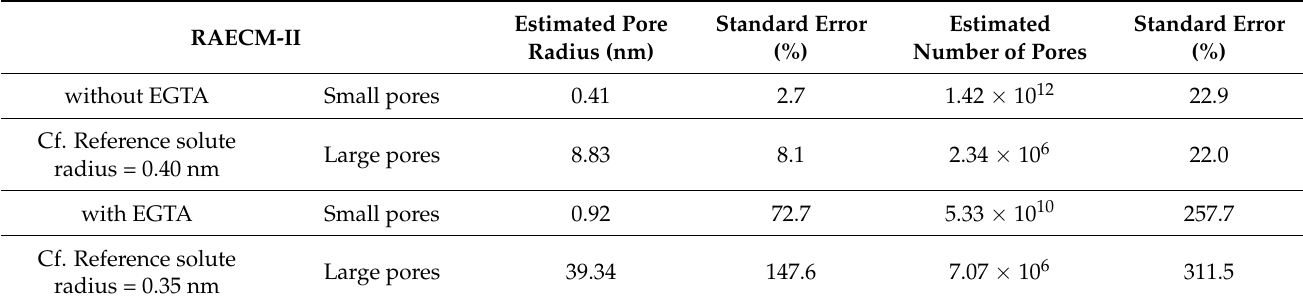
Table A5. Radius and number of small and large equivalent pore populations based on maximum likelihood optimization approach using the mean of P app for each solute in the absence and presence of EGTA. Equivalent pore number is per nominal surface area (1 cm 2 ) of RAECM-II.